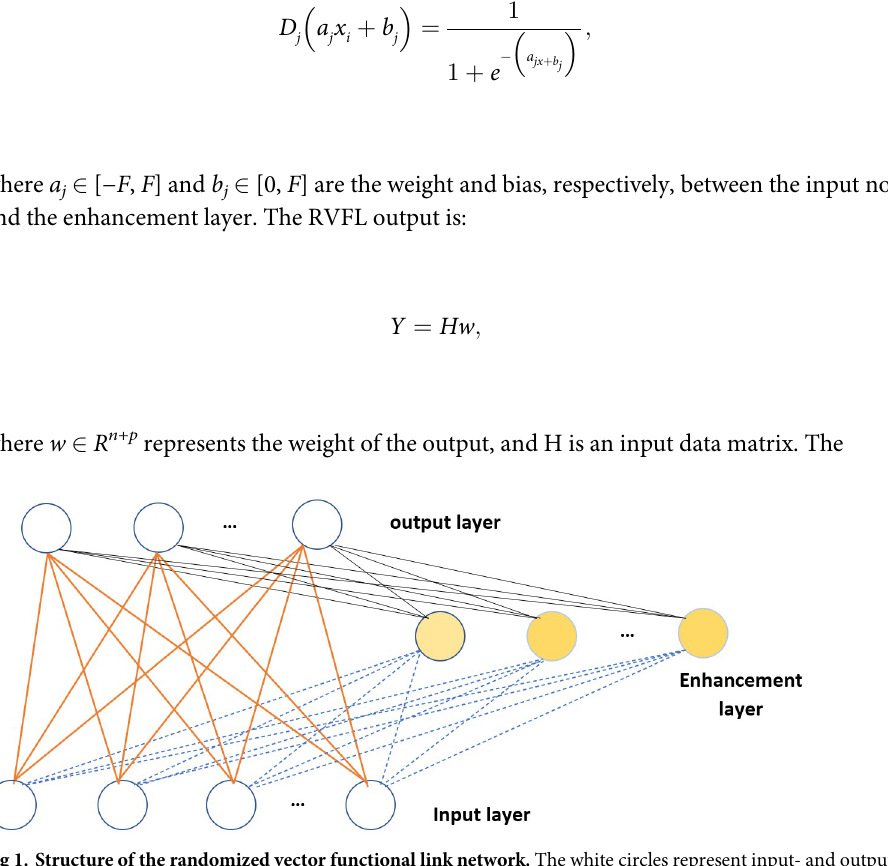
Fig 1. Structure of the randomized vector functional link network. The white circles represent input- and output- layer nodes, whereas the yellow circles represent enhancement-layer nodes.